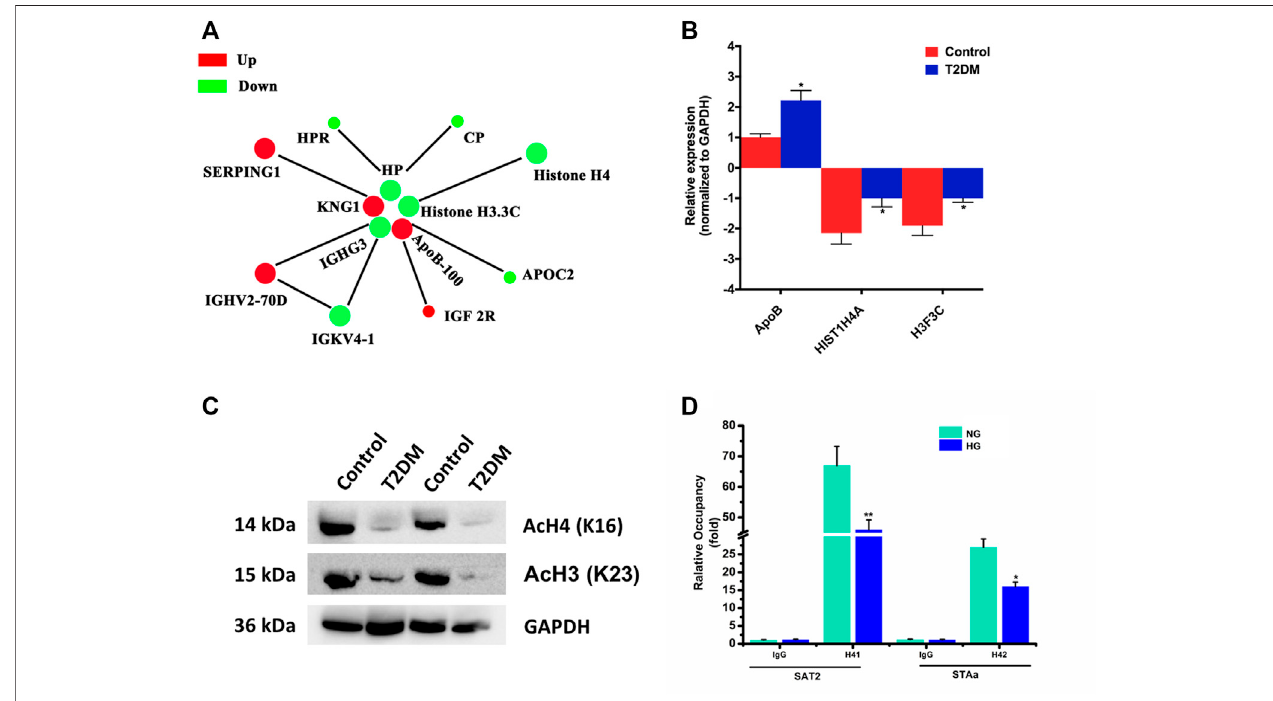
FIGURE 7 | (A) Protein – protein interaction network for proteins corresponding to differentially expressed modi fi cation sites. Different colors represent differential modi fi cationsoftheprotein(greenisthedownregulatedandredistheupregulated). (B) Proteinscorrespondingtodifferentiallyexpressedmodi fi cationsitesvalidatedby qRT-PCR. All PCRs were performed in triplicate. The data are represented as means ± SD. (C) Western blot detection of H4K16 and H3.3CK23 acetylation levels between Uyghur T2DM and the control group. (D) Using ChIP to detect H4 acetylation levels of SAT2 and STAa in INS-1 cells of different groups. * p < 0.05, ** p < 0.01.